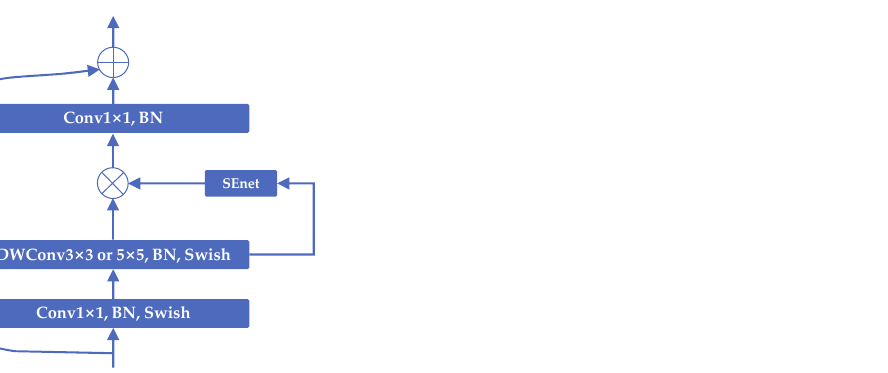
Figure 3. The structure of MBConvBlock. SENet is an attention mechanism. BN is the Batch- Norm, which serves to normalize the data. Swish is an activation function. DWConv is the Depthwise